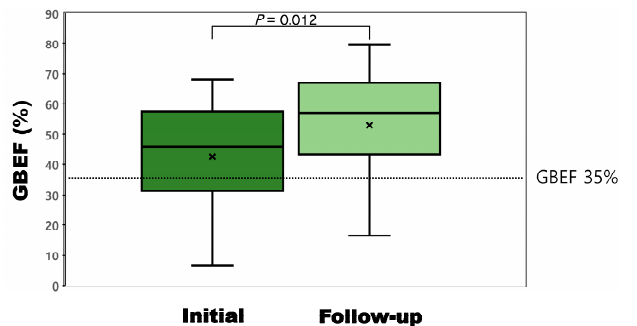
Figure 3. Boxplots for the GBEFs at the initial and follow-up measurements. The mean GBEFs at the initial and follow-up measurements were 42.6% (range, 6.5–68.2%) and 53.0% (range, 16.6–79.6%), respectively. The 10.4% change in GBEF was significant ( p = 0.012). GBEF, gallbladder ejection fraction. Table 3. Comparison of the GBEFs at the initial and follow-up (after Rowachol treatment) measure- ments.